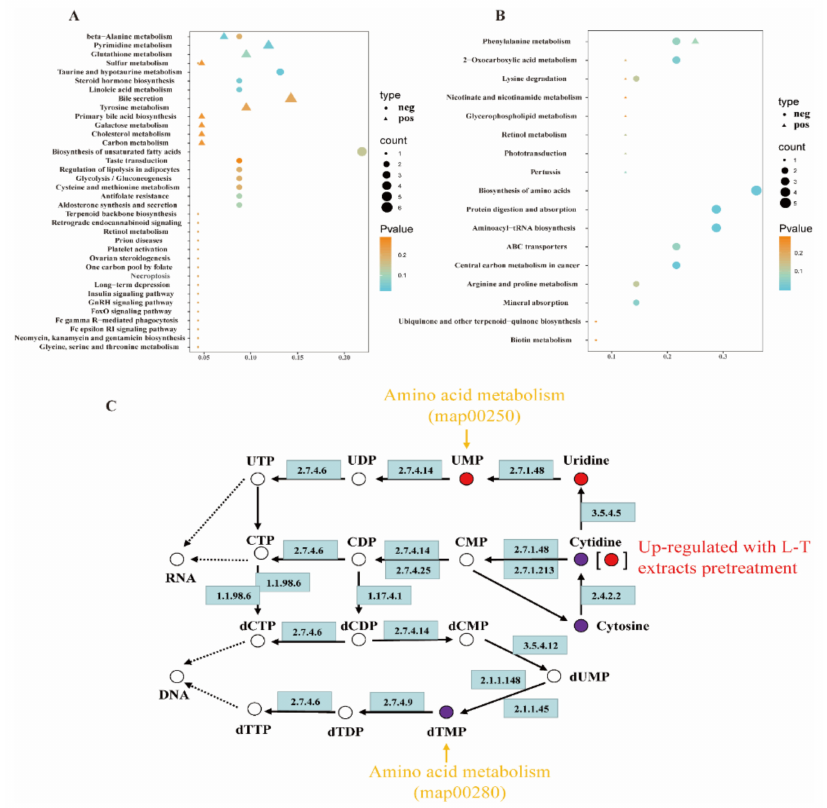
Figure 4. Analysis of the global metabolic pathways with L-theanine and DSS. ( A , B ) The metabolic pathways enrichment results of the DSS group compared to the control group and LTD group compared to the DSS group with P -value < 0.3. ( C ) The regulated biomarkers during Pyrimidine metabolism. Cytidine, cytosine, and dTMP (purple point) were down-regulated in the DSS group compared to the CON group. Cytidine, UMP and Uridine (red point) were up-regulated in LTD group compared to DSS group. UMP and dTMP (yellow arrow) are the metabolisms of the amino acids of L-theanine treatment regulation. Different numbers in the blue background indicate different enzymes (refer to KEGG pathway